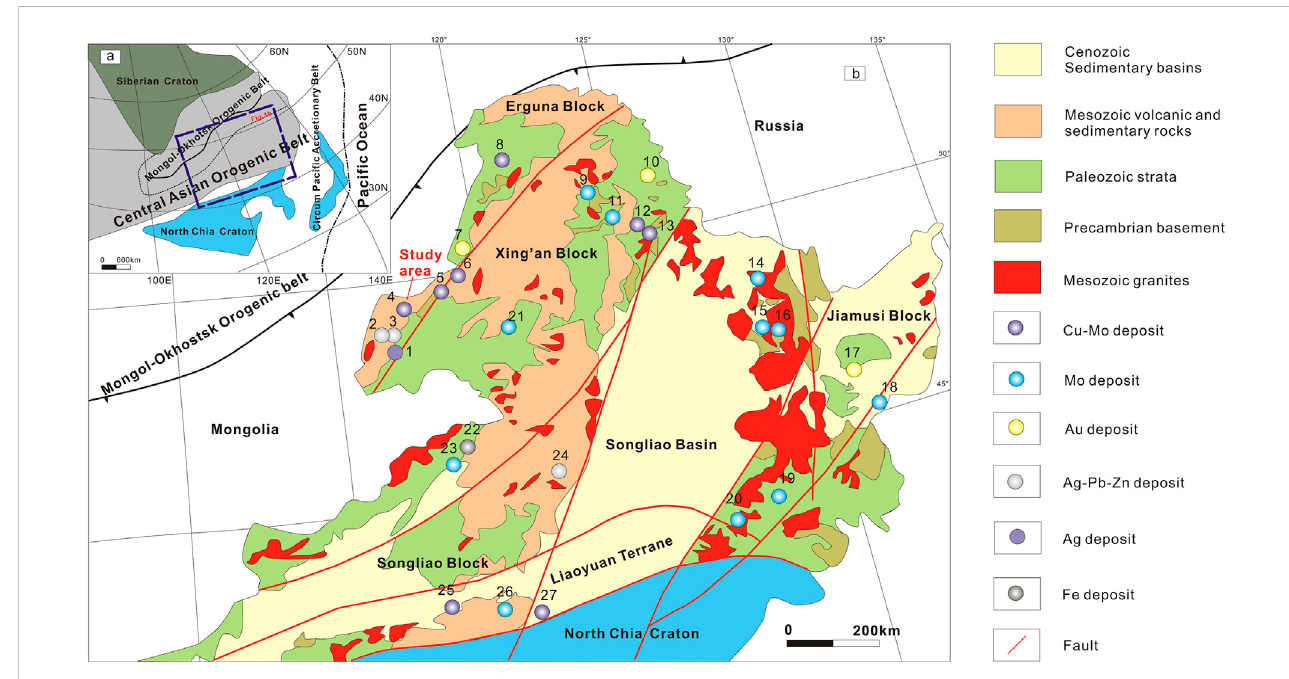
FIGURE 1 (A) Geological map of NE China (after Safonova, 2009), showing (B) distribution of Mesozoic igneous rocks and ore deposits (modi fi ed from Wu et al., 2014). Names of ore deposits: 1 – Erentaolegai Ag deposit; 2 – Chaganbulagen Ag – Pb – Zn deposit; 3 – Jiawula Ag – Pb – Zn deposit; 4 – Wunugetushan Cu – Mo deposit;5 – Babayi Cu – Modeposit;6 – BadaguanCu – Modeposit;7 – Xiaoyinuogaigou Audeposit;8 – Taipingchuan Cu – Mo deposit;9 – ChalukouMo deposit; 10 – Sandaowanzi Au (Sb)deposit; 11 — Xinga Mo deposit; 12 – Duobaoshan Cu – Mo deposit; 13 – Tongshan Cu – Mo deposit; 14 – Huojihe Mo deposit; 15 – Cuiling Mo deposit; 16 – Luming Mo deposit; 17 – Laozhashan Au deposit; 18 – Jinchanggou Mo deposit; 19 – Dashihe Mo deposit; 20 – Daheishan Mo deposit; 21 – Taipinggou Mo deposit; 22 – Chagan ’ aobao Fe – Zn deposit; 23 – Diyanqinamu Mo deposit; 24 – Meng ’ entaolegai Pb – Zn – Ag